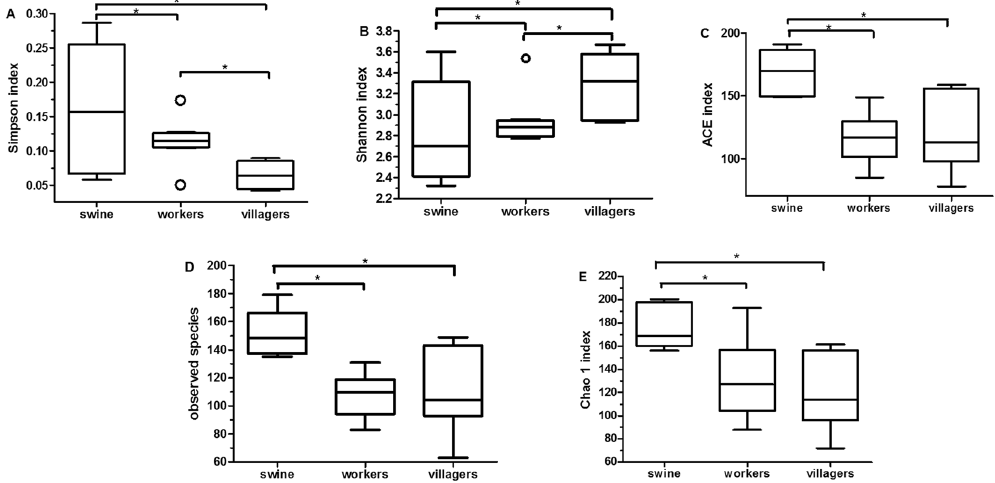
Figure 1. Box plots of diversity and richness estimators. Panel (A): Simpson index; Panel (B): Shannon index; Panel (C): Abundance-based coverage (ACE); Panel (D): Observed species; and Panel (E): Chao 1 index. “O” indicates outlier values, * p <